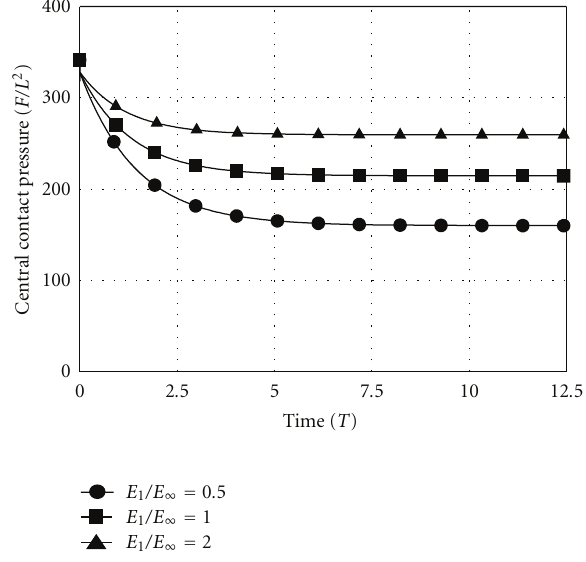
Figure 12: E ff ect of E 1 /E ∞ on relaxation of the central contact pressure.